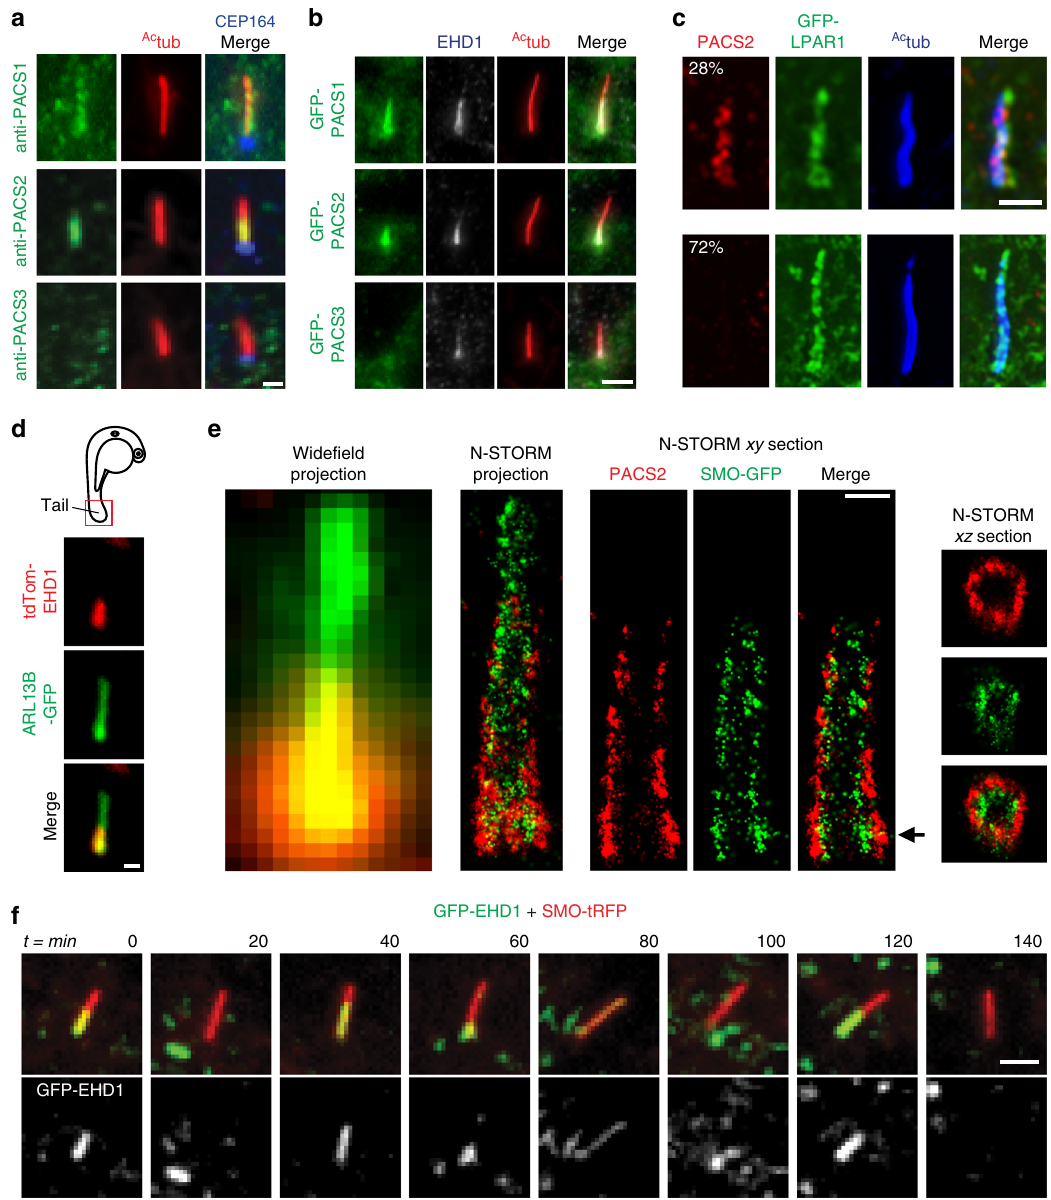
Fig. 2 PACSIN and EHD proteins display dynamic CPM traf fi cking. a Representative images of RPE-1 cells serum starved for 24 h and stained with antibodies for PACSINs, Ac tub, and CEP164. PACSIN2 antibody showed lower levels of background staining in RPE-1 cells as compared to the PACSIN1 antibody. b Representative images of GFP-PACSINs expressed in RPE-1 cells as in a and stained with antibodies for EHD1 and Ac tub. Note that GFP- PACSIN1 and GFP-PACSIN2 always co-localized with EHD1 (GFP-PACSIN1 = 85, GFP-PACSIN2 = 90 cells). SDC images in a and b are maximum intensity z-projections. Scale bar: 2 μ m. c N-SIM images of cilia from cells transiently transfected with GFP-LPAR1, serum starved for 24 h, and stained with Ac tub and PACSIN2 antibodies. Images are single xy planes. Scale bar: 2 μ m. d Representative image of tdTom-EHD1 and the ciliary membrane marker ARL13B- GFP expressed in a cilium from the tail region (red box in schematic; top panel) of a 24 hpf embryo. SDC images are maximum intensity z-projections. Scale bar: 1 μ m. e Representative images of epi fl uorescence (left panel) and N-STORM projections (middle left panel) from 24 h serum-starved SMO-GFP RPE-1 cells stained with PACSIN2 antibody as described in Methods. Images of a single xy plane bisecting the cilium (middle right panels). Orthogonal views of N-STORM images corresponding to the black arrow (right panels). Scale bar: 300 nm. f GFP-EHD1 + SMO-tRFP cells were serum starved for 24 h and imaged live every 20 min. Images are single xy planes (30 ciliated cells). Scale bar: 2 μ